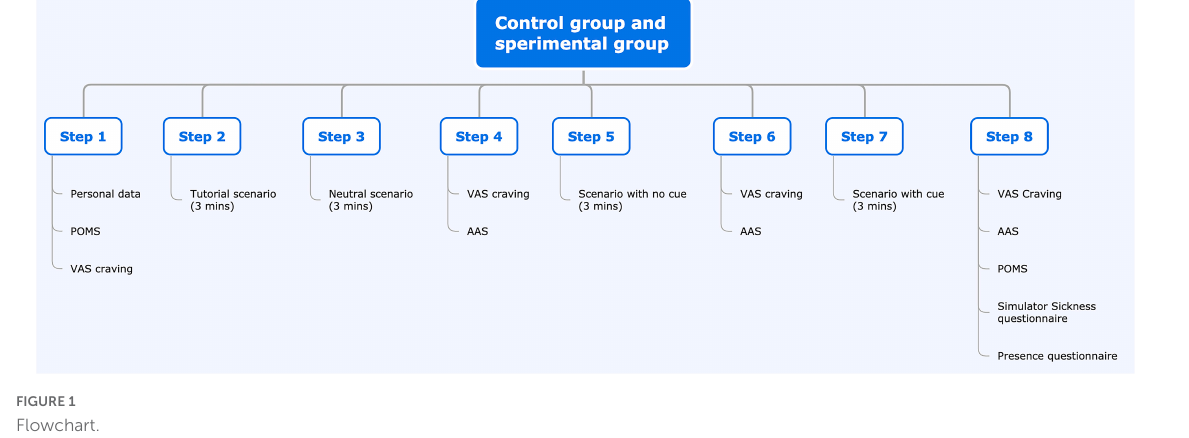
FIGURE1 Flowchart.